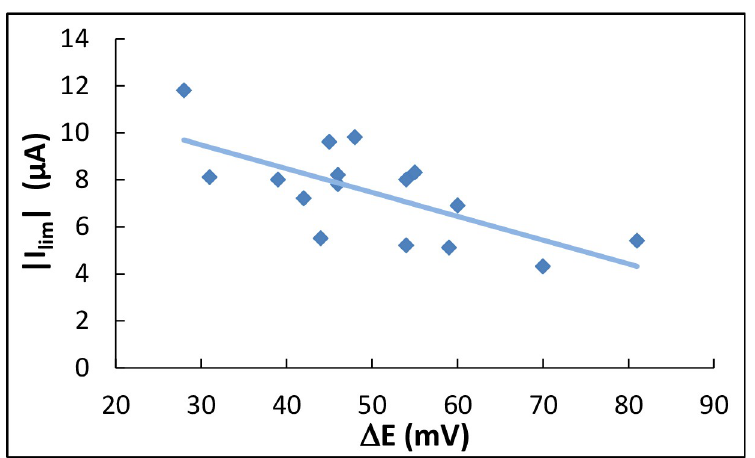
Fig 5. Limiting current (absolute value) as a function of the potential shift Δ E (from Table 1). The continuous line is the linear regression.